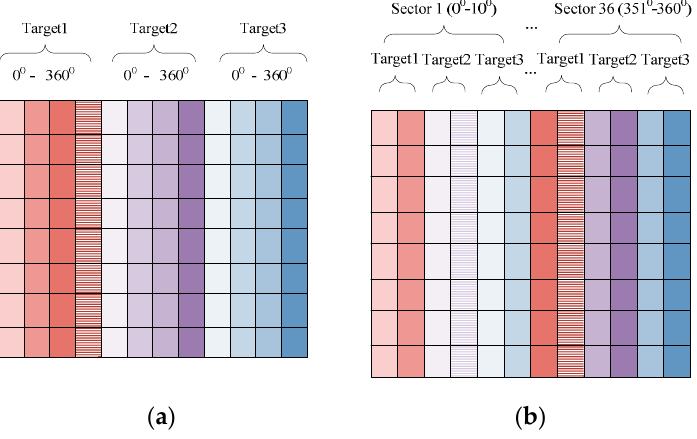
Figure 3. Dictionary structure. ( a ) Traditional dictionary. ( b ) Proposed dictionary with local aspect sectors.